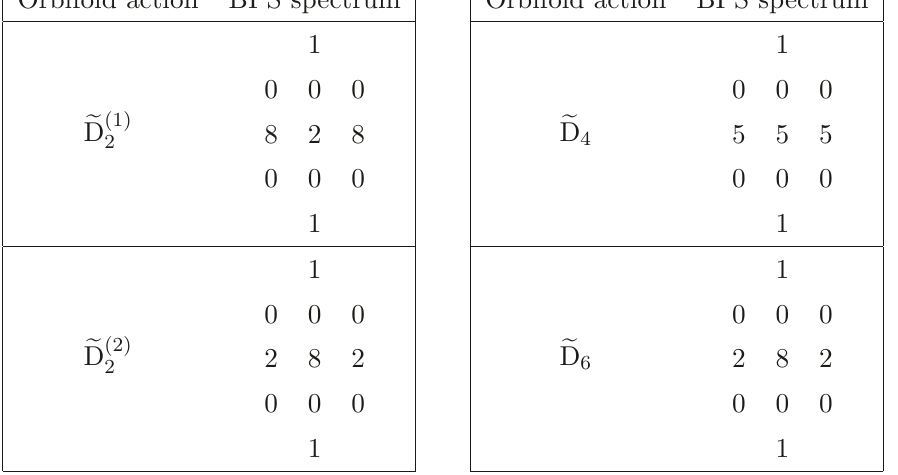
Table 2 . BPS spectra of the torus orbifolds with the inclusion of discrete torsion. Again, the entries are the non-vanishing Hodge numbers h p,q , where p, q ∈ { 0 , 1